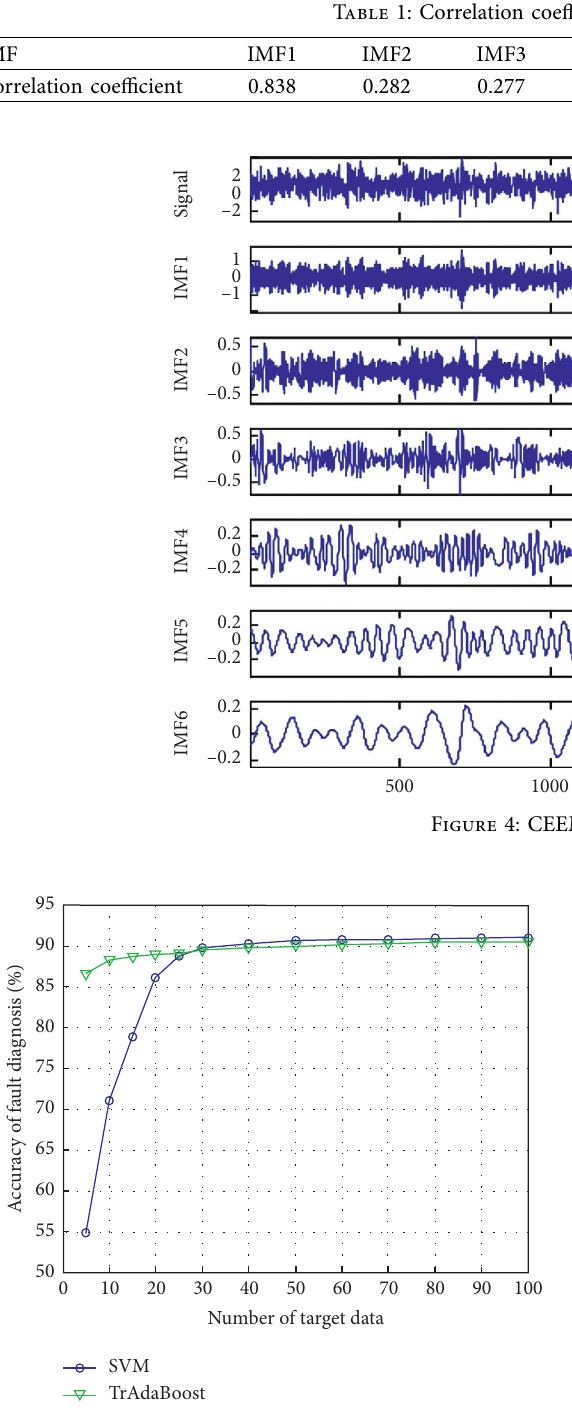
Figure 5: Comparison of correct rate of transfer learning and machine learning